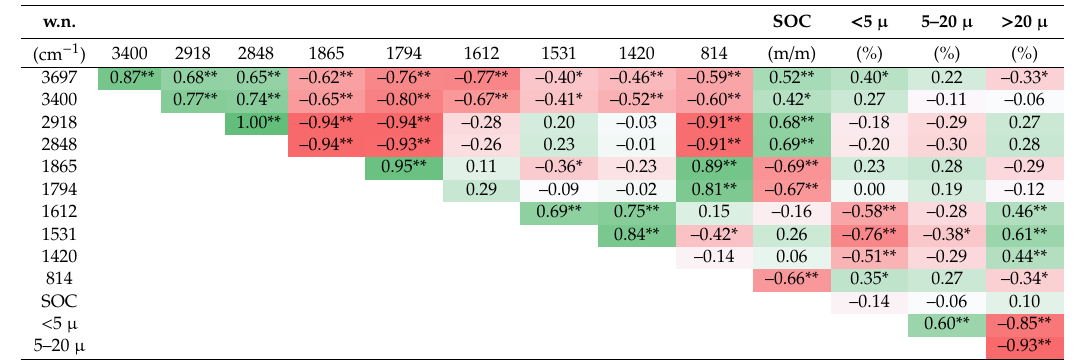
* indicates significance at 95% probability. ** indicates significance at 99%